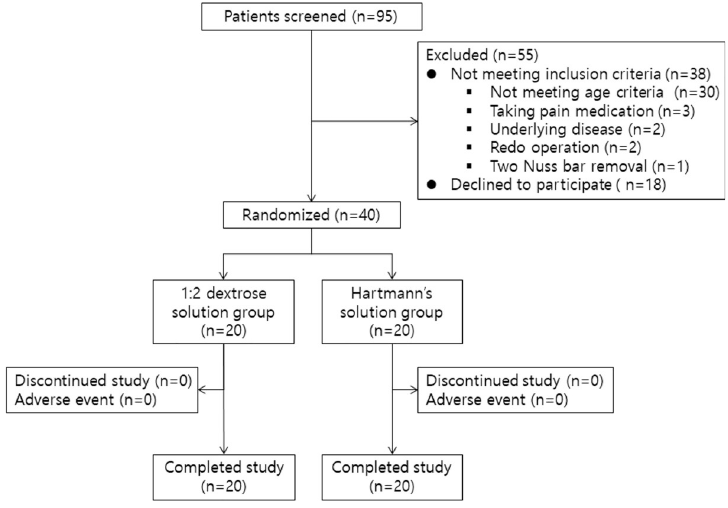
Fig 1. Consort flow chart.